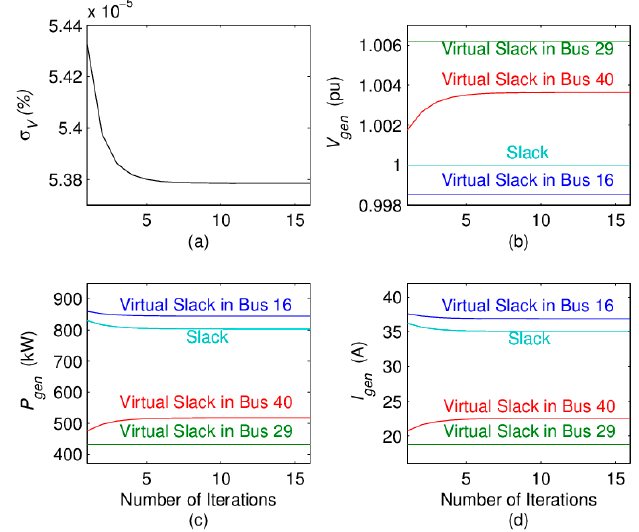
Figure 6. Result of optimal current flow analysis with constraints: ( a ) Root-mean-square- deviation of all bus voltages. ( b ) Voltages, ( c ) powers, and ( d ) currents of slack and virtual slacks.